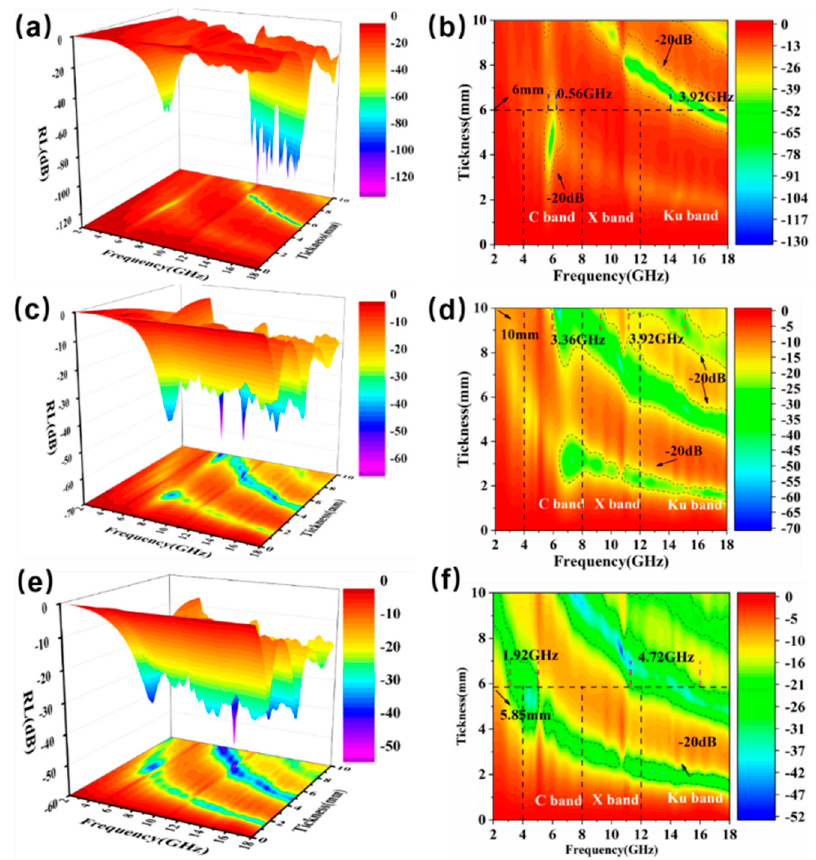
Figure 5. 3D representation and contour plots of the reflection loss of CIP@MnO 2 composites at different filling ratios: 20 wt% ( a , b ), 40 wt% ( c , d ), and 60 wt% ( e , f ).